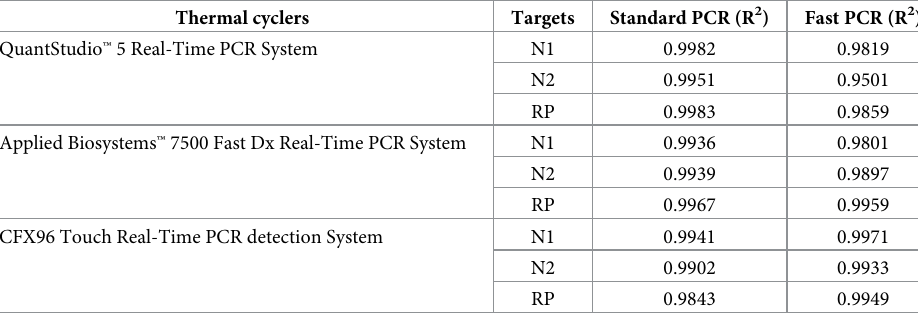
Table 3. Comparison of efficiency between standard PCR and Fast PCR.